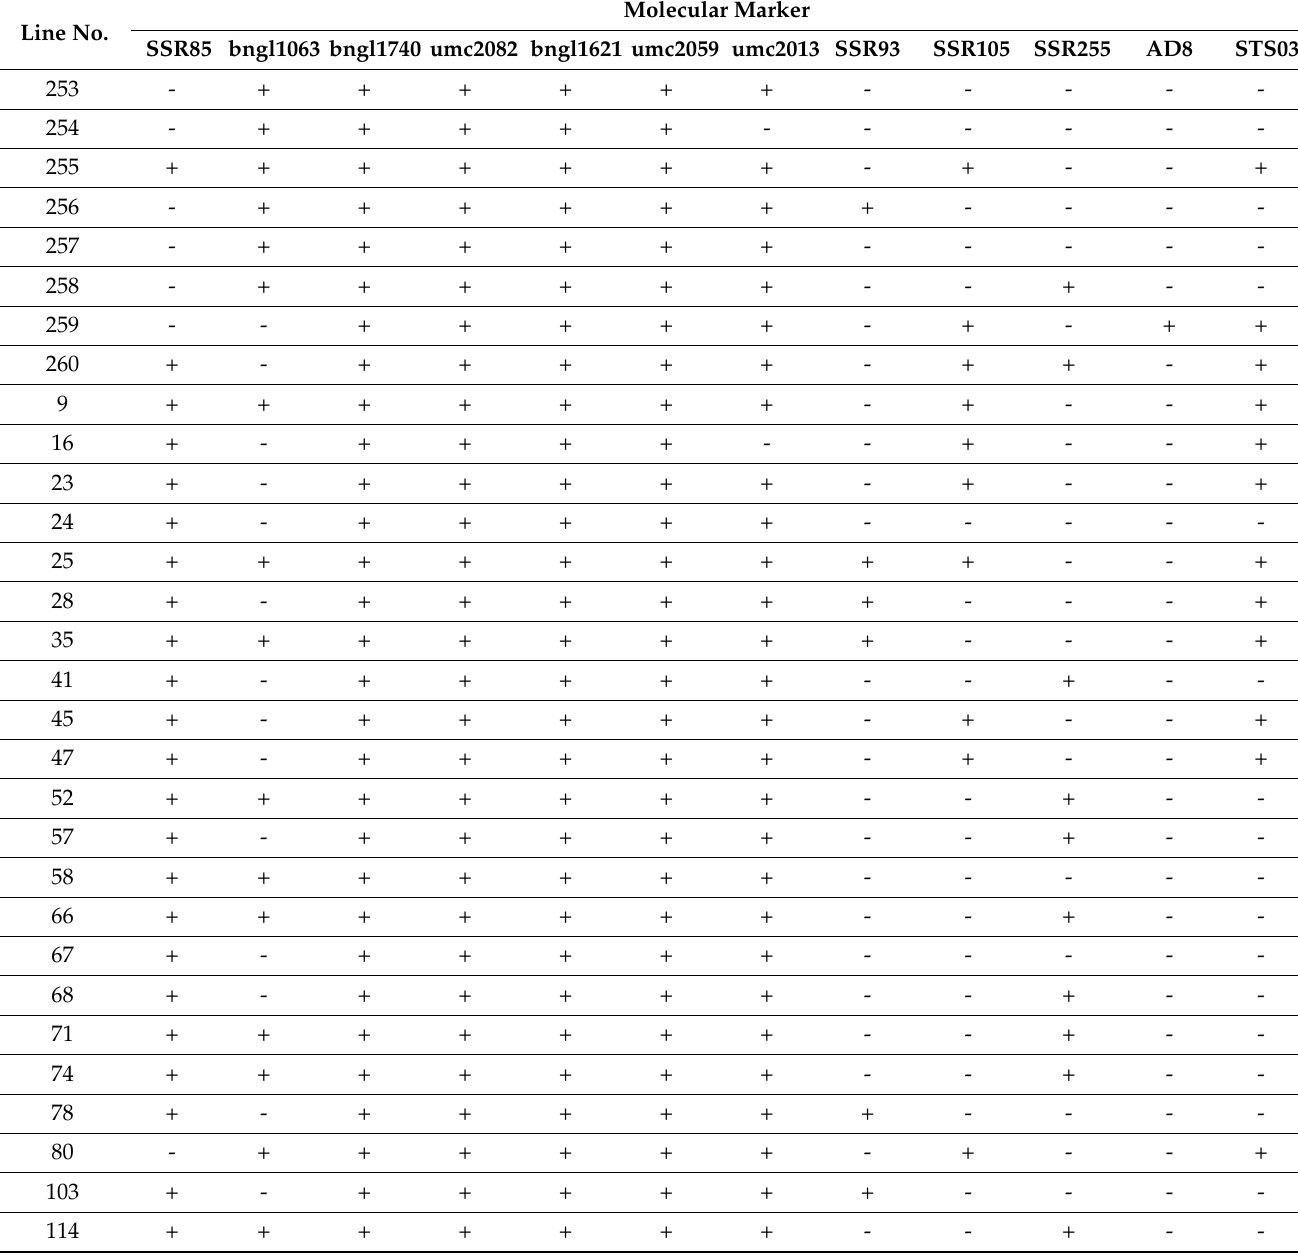
Table 4. Molecular markers linked to plant resistance to fusarium present in the analyzed lines.